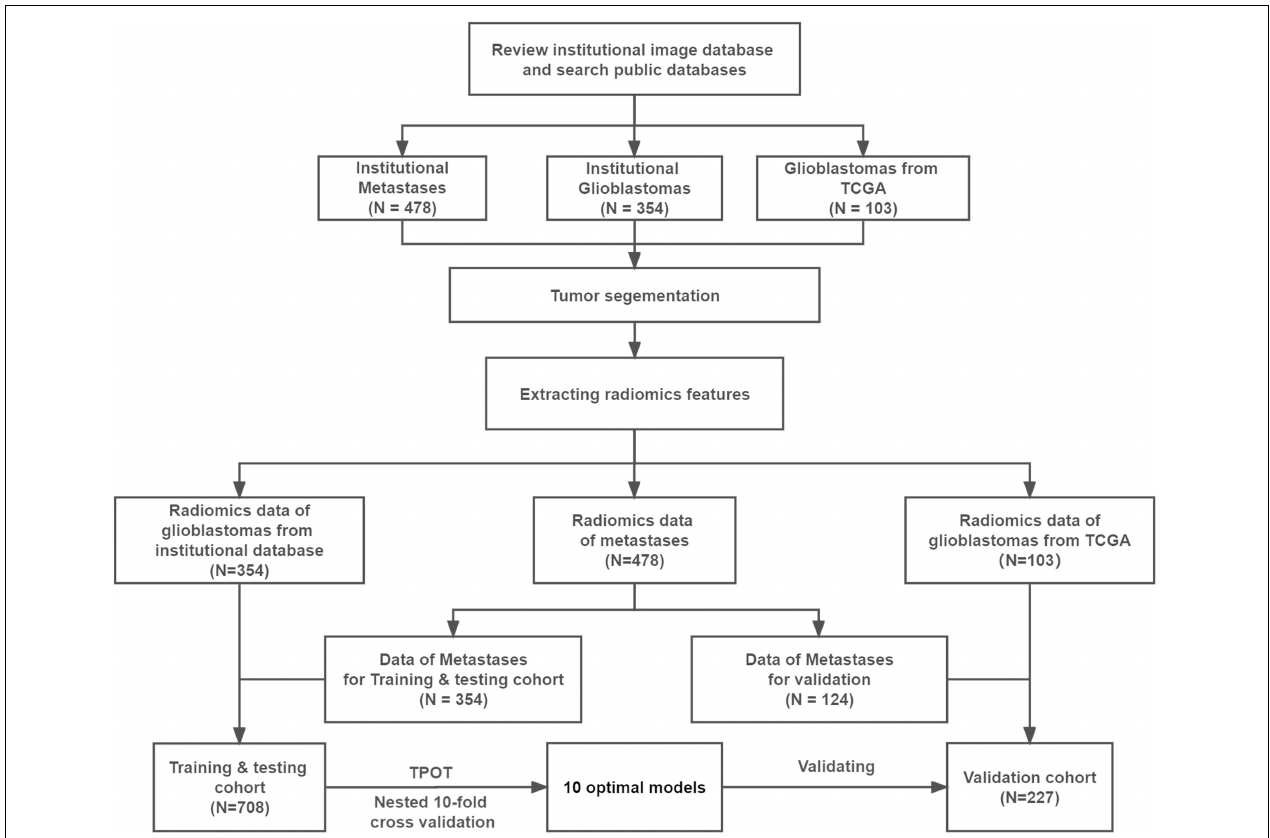
FIGURE 1 | Study flowchart. TCGA, the cancer genome atlas; TPOT, tree-based pipeline optimization